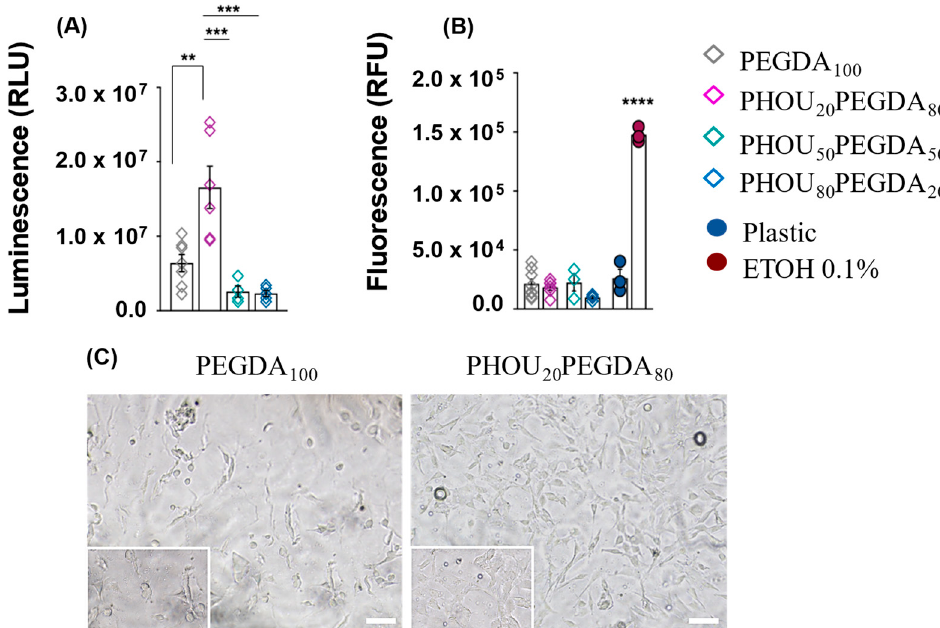
Figure 9. Evaluation of PHOUxPEGDA 1 − x biomaterial biocompatibility. C2C12 cells were seeded at the same density (3000 cells/cm 2 ) on 1 cm 2 biomaterials and expanded for 5 days in Growth Medium. Measurement of luminescence (RLU) associated with viability of the cells ( A ) and of fluorescence (RFU) associated with cytotoxicity after expansion on the biomaterials ( B ). C2C12 cells incubated with 0.1% of ethanol diluted in GM for 30 min were used as positive control of toxicity. C2C12 cells expanded on plastic dish were used as negative control. Data are represented as the mean ± s.e.m of 4 to 7 independent experiments. Statistical significance was determined by One way ANOVA tests followed by Tukey’s multiple comparisons test, with ** p < 0.01, *** p < 0.001 and **** p < 0.0001. ( C ) Representative photomicrons showing C2C12 cell morphology and density after 5 days of culture on PEGDA 100 and PHOU 20 PEGDA 80 . Inlets show higher magnification. Scale bars: 50 µm.